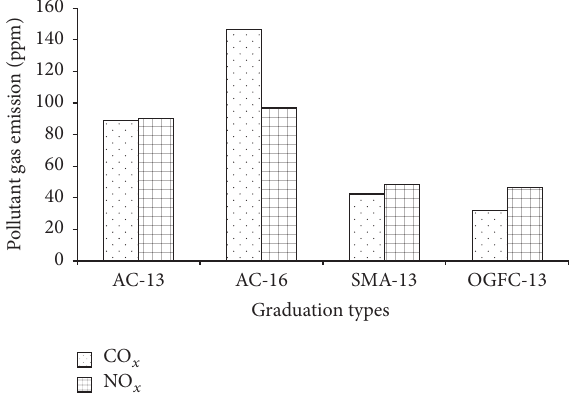
Figure 7: Gradation types and pollutant